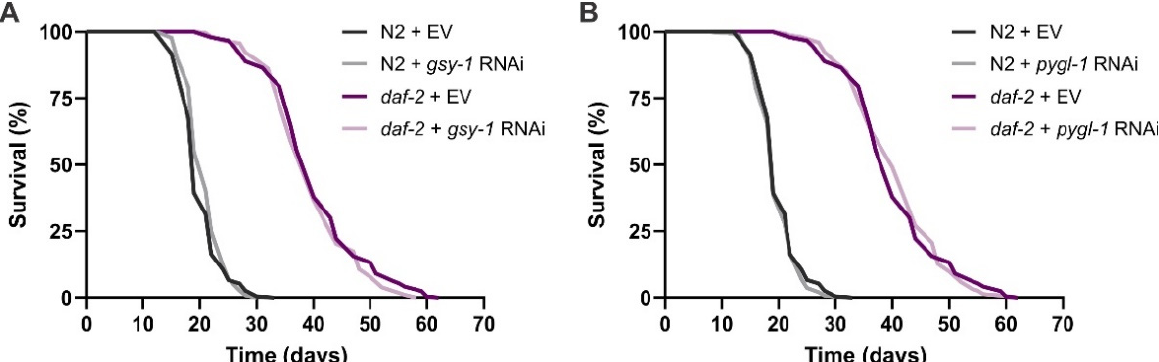
Figure 1. The role of glycogen accumulation in daf-2(e1370) longevity: survival curves of wild-type N2 and daf-2(e1370) mutants exposed to ( A ) gsy-1 and ( B ) pygl-1 RNAi starting from hatching. The graphs represent pooled data from two independent experiments. EV—empty vector control. The data are summarized in Table S1.